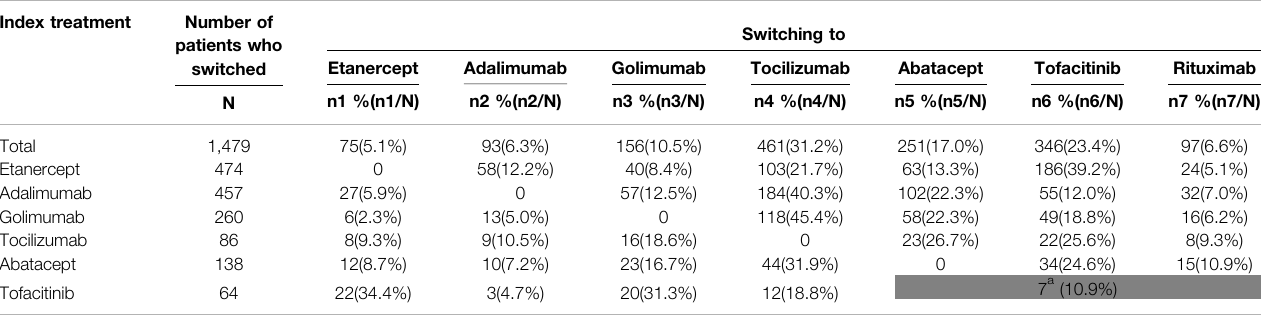
TABLE 3 | Treatment regimen for patients who switched from the index treatment a .